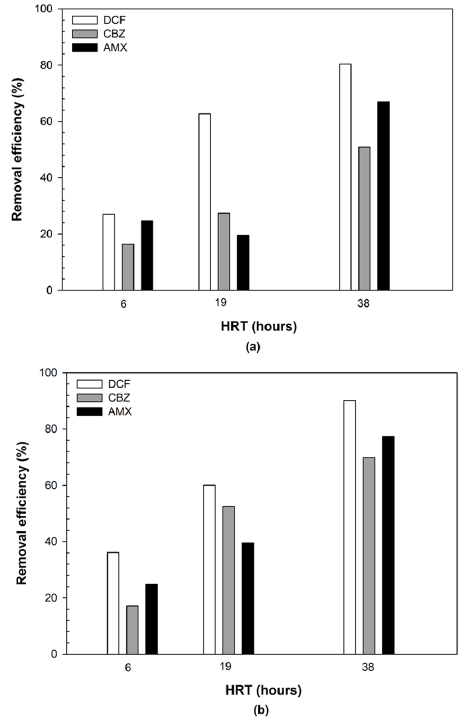
Figure 5. Effects of HRT on the removal of pharmaceuticals by the electrochemical process at an initial concentration of 0.01 mg/L ( a ) and 10 mg/L ( b ) (j = 0.5 mA/cm 2 ).